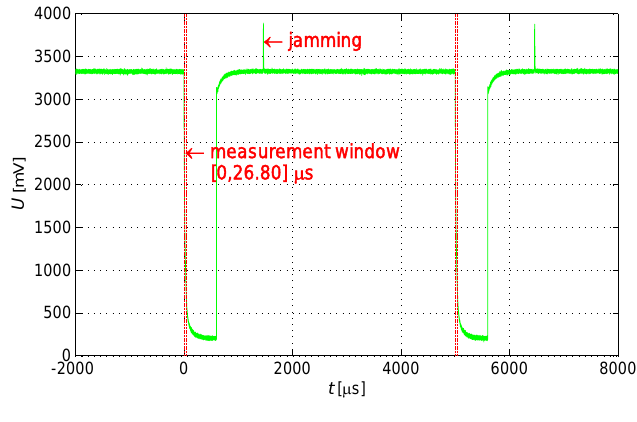
Figure 23. An anti-jamming process.